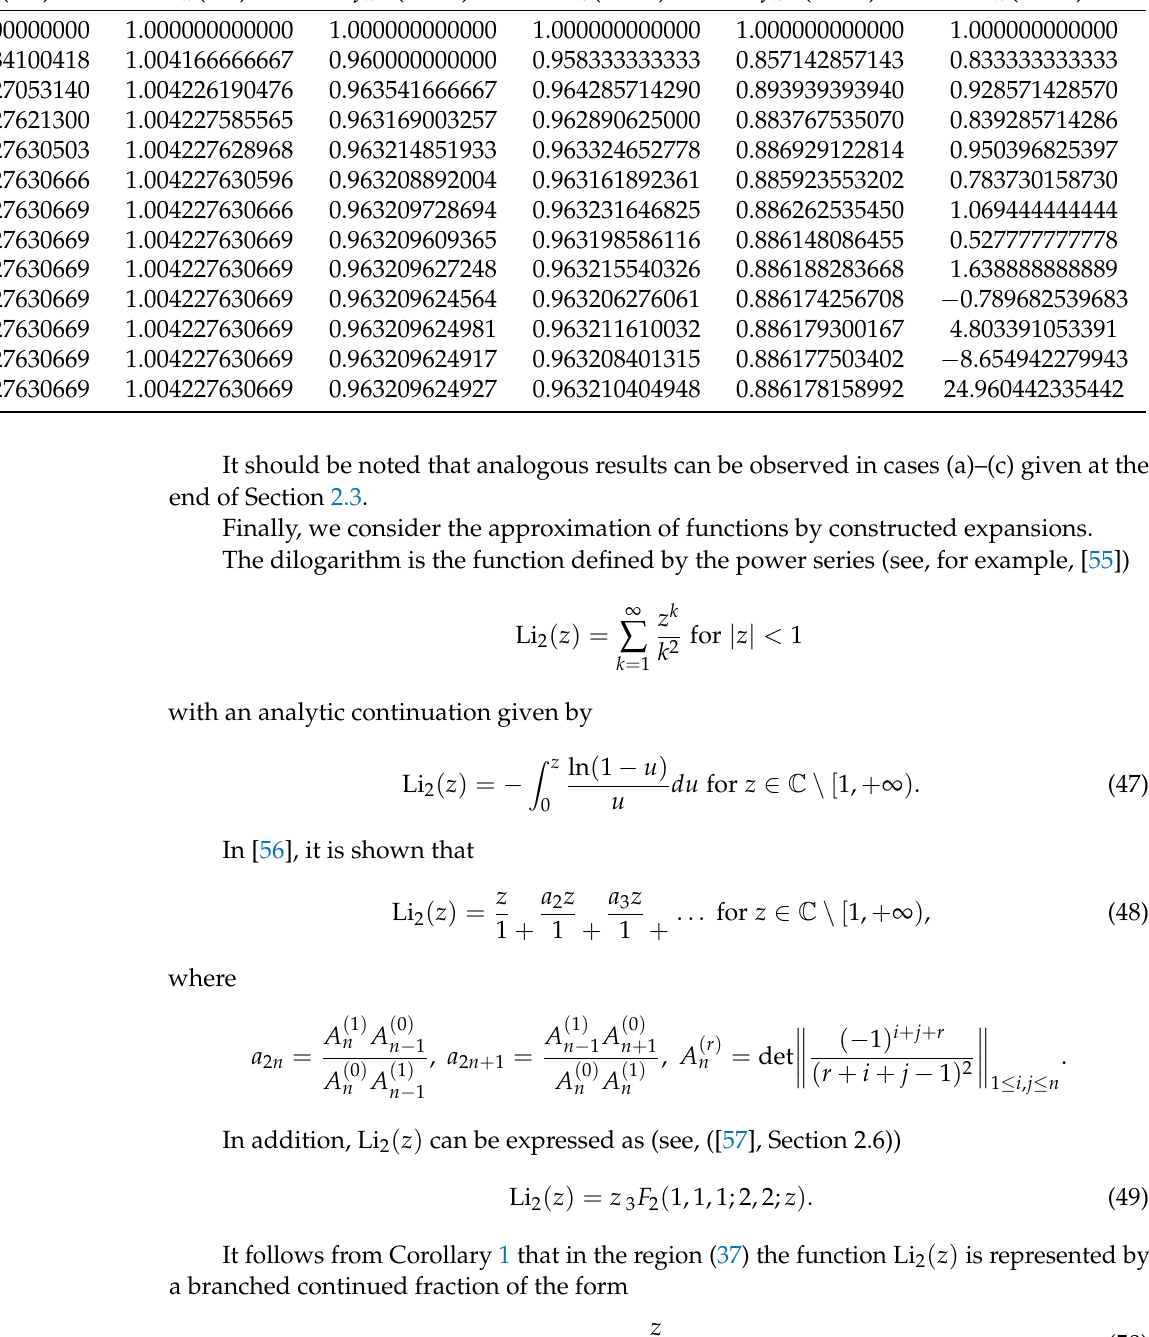
Table 1. Approximation of the solution of differential Equation (46) by the branched continued fraction (45) and the generalized hypergeometric series 3 F 2 ( 1,1/2,1;6,2; z ) . n f 1,1 n ( 0.1